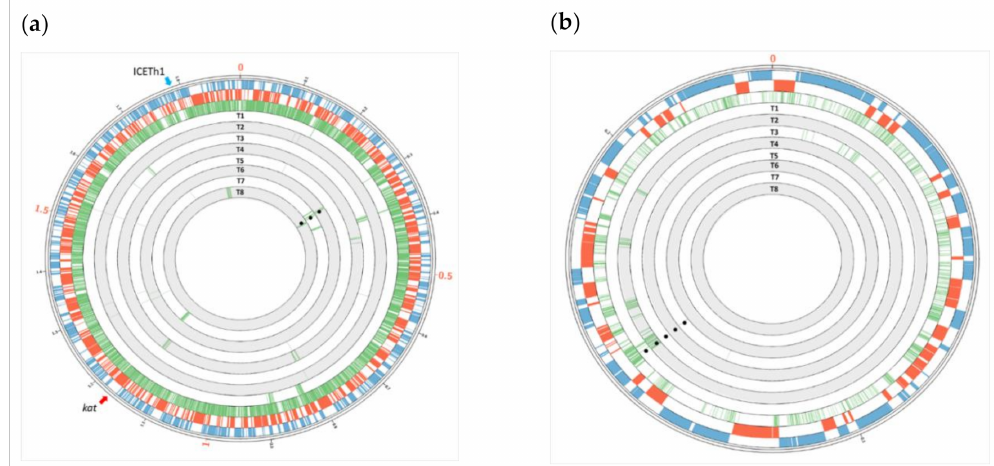
Figure 2. ( a ) Chimeric nature of the chromosome of retrotransjugants derived from HB27. External blue and red circles indicate the positions of forward and reverse annotated ORFs in the chromosome of the HB27 strain, respectively. Green bars in the first internal circle indicate the positions of the single nucleotide polymorphisms (SNPs) present in the chromosome of the HB8 strain. Underlying concentric circles correspond to the genome of transjugants T1 to T8 from the outermost to the innermost circles, respectively. Presence of green lines denotes SNPs acquired from the HB8 strain back into an HB27 background genome. ( b ) Chimeric nature of the pTT27 megaplasmid of retro-transjugants derived from HB27. External blue and red circles indicate the positions of forward and reverse annotated ORFs in the pTT27 megaplasmid of the HB27 strain, respectively. Green bars in the first internal circle indicate the positions of the SNPs present in the pTT27 megaplasmid of the HB8 strain. Underlying concentric circles correspond to the genome of transjugants T1 to T8. The presence of green lines denotes SNPs acquired from the HB8 strain back into an HB27 background megaplasmid. Position of the kat gene is labeled with a red arrow and the hph gene is labeled in black dots. The position of ICETh1 is labeled as a blue